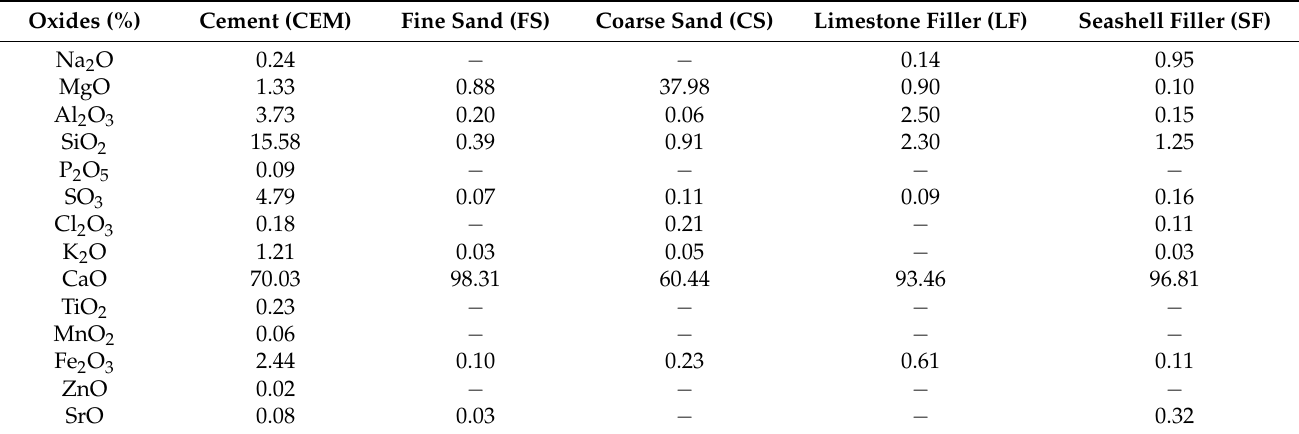
Table 2. XRF chemical composition of the raw